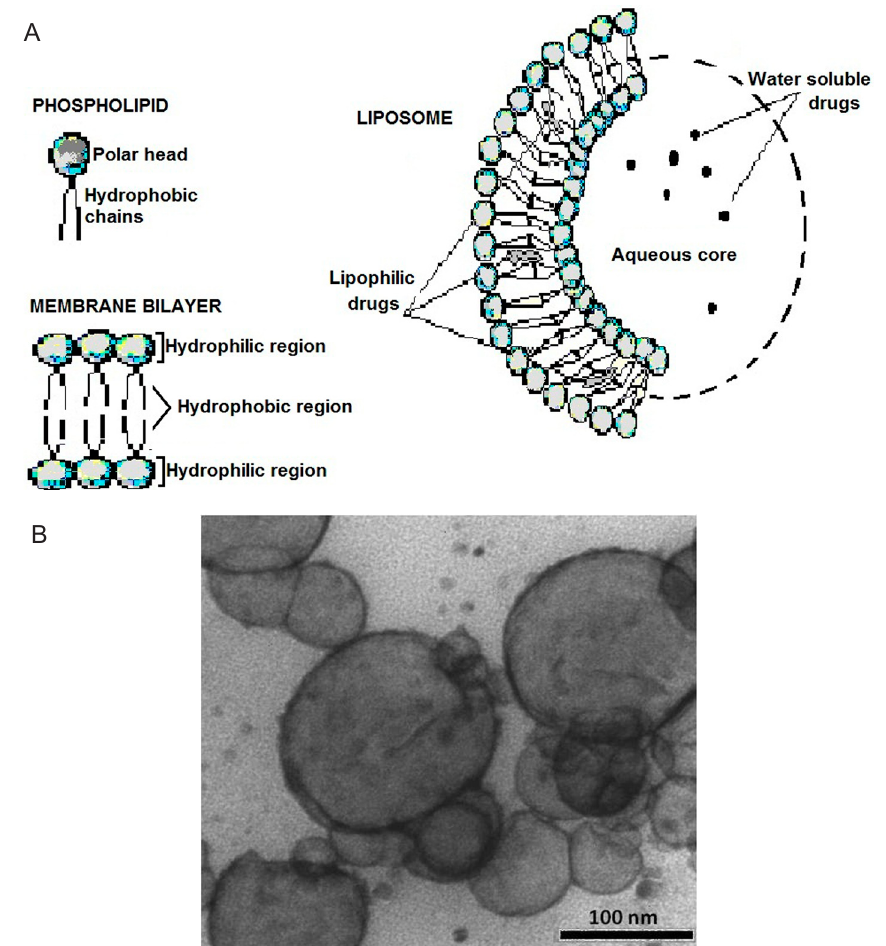
Figure 2. A , Liposomes are basically composed of a phospholipid bilayer surrounding an aque- ous core; they function as containers in which several chemically different compounds can be entrapped or to which they can be attached. Hydrophobic drugs can be associated with the lipid membrane while the hydrophilic ones can be dissolved in the aqueous core. B , Transmission electron microscopy images of liposomes. The small black particles are artifacts produced during sample preparation for